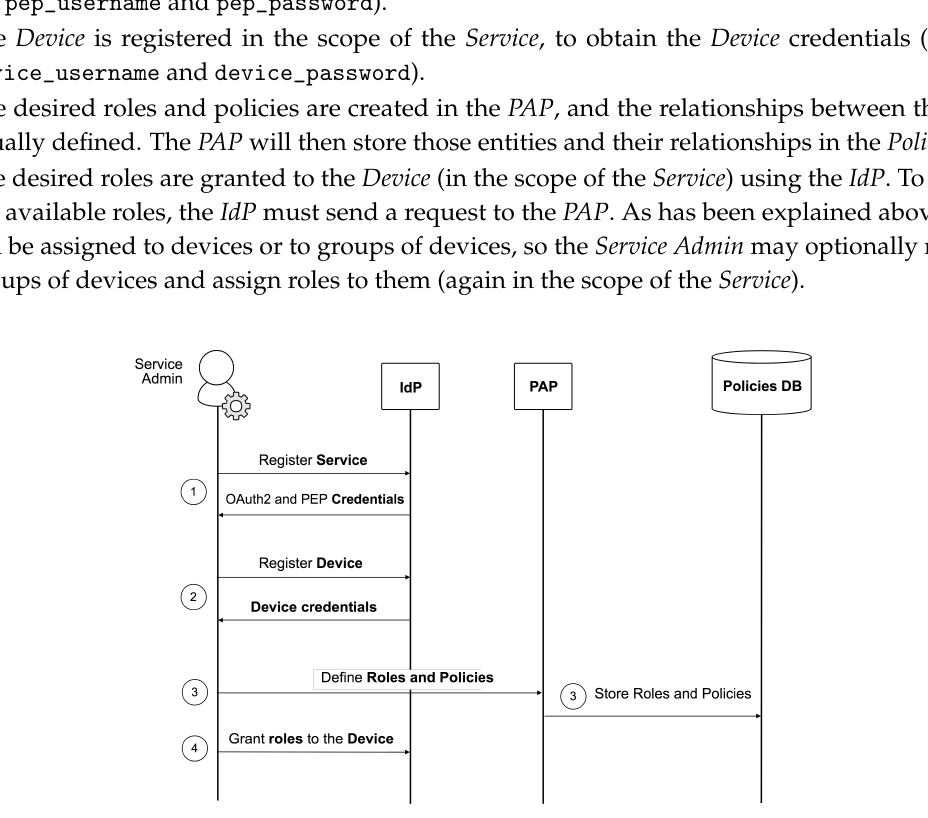
Figure 2. Registration and configuration of the Service and the Device